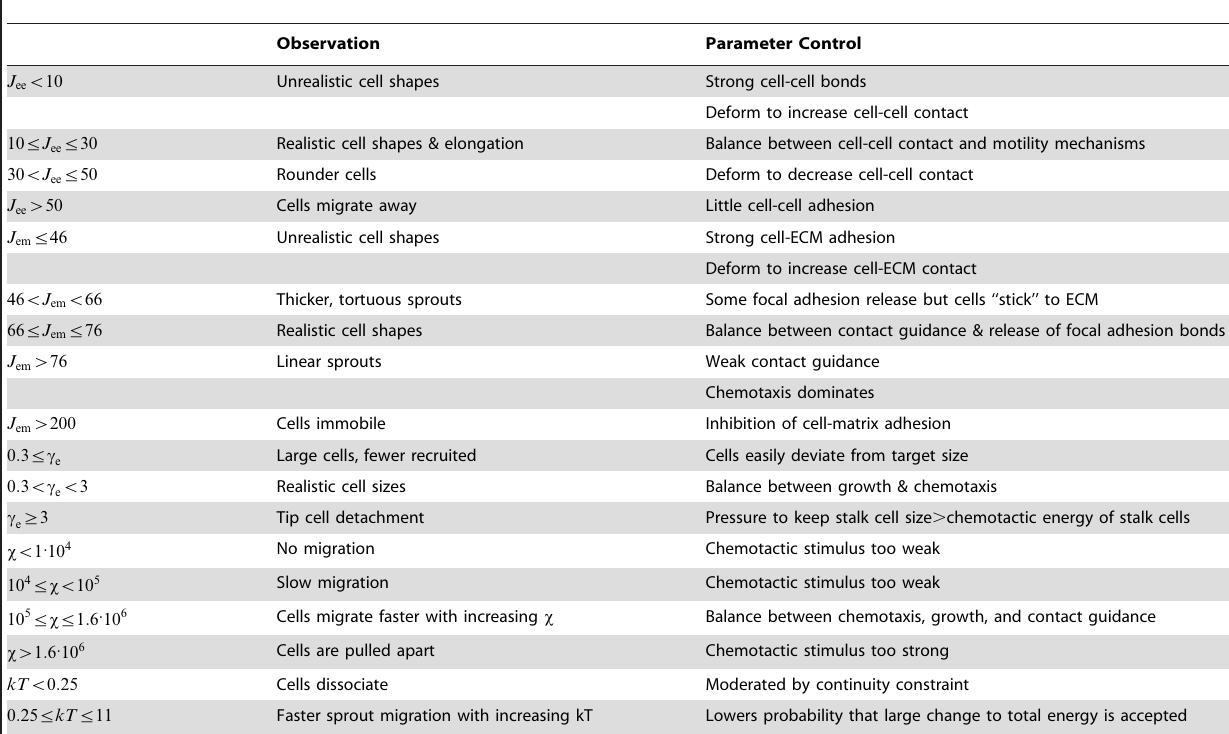
Table 3. A summary and explanation of the effects of parameter perturbation in the sensitivity analysis.